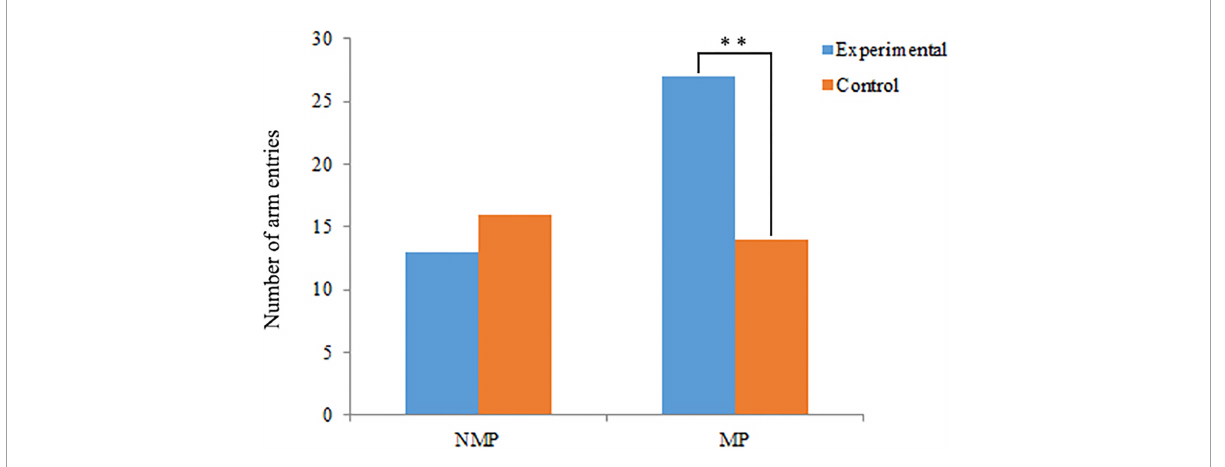
FIGURE2 Behavioral assays of male Procambarus clarkii during the non-mating period (NMP) and mating period (MP). ∗ Represents the significant differences between experimental and control groups ( P < 0.05, n = 50). The numbers of no choice were excluded from the statistical